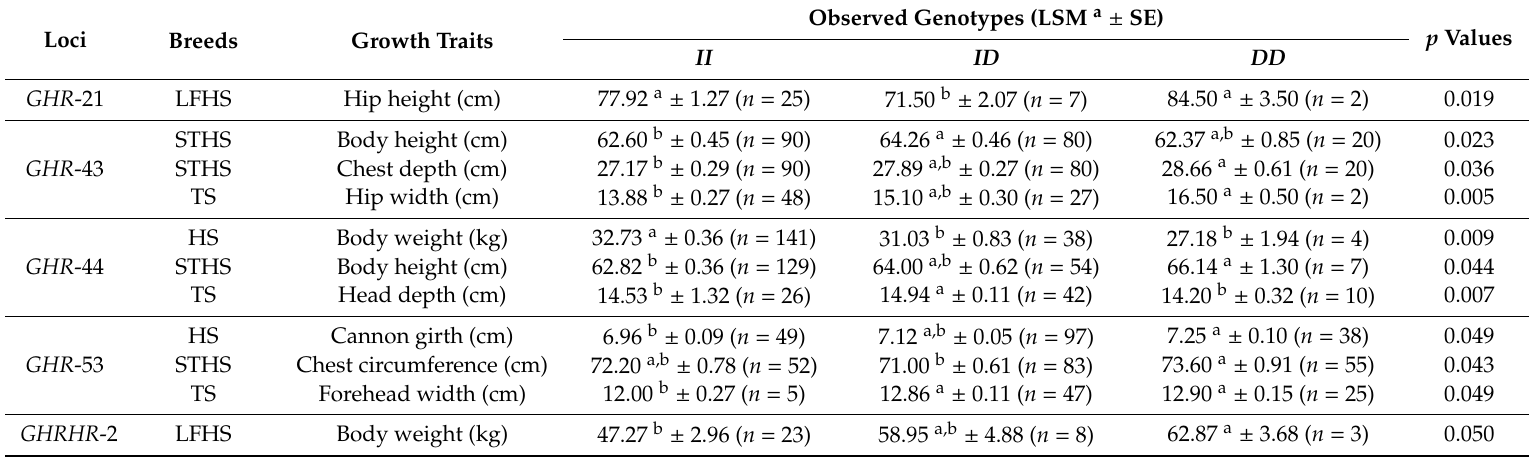
Table 4. Relationship between variations of GHR , GHRH, and GHRHR and their growth